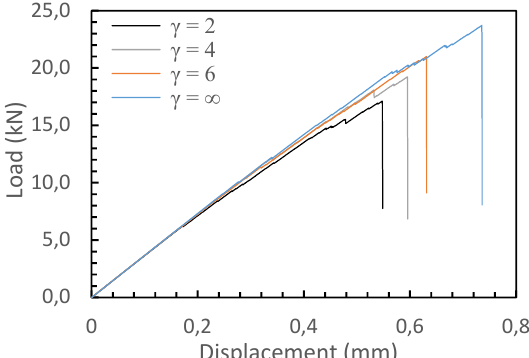
Fig. 2. Load as a function of deflection from agglomerate tests for various Weibull shape parameter γ.